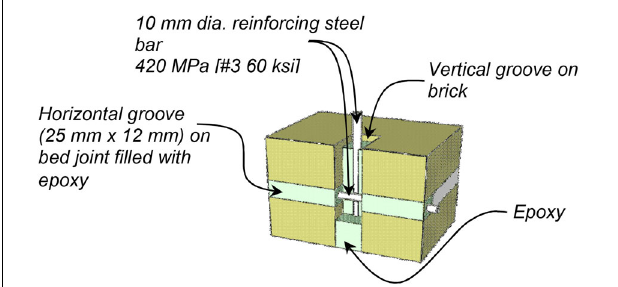
FIGURE 3 | Near-surface mounted reinforcing steel bars placed into pre-cut grooves.